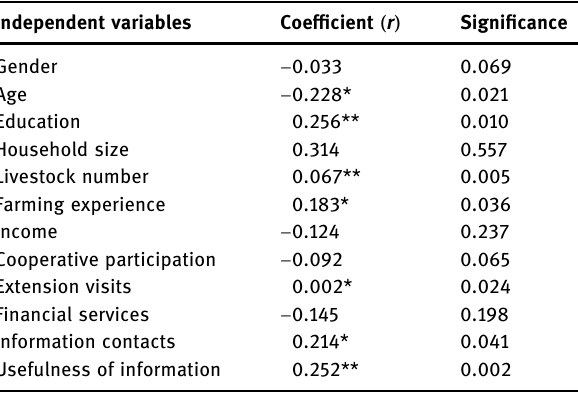
Table 6: Correlation of TIS with respondents ’ socioeconomic